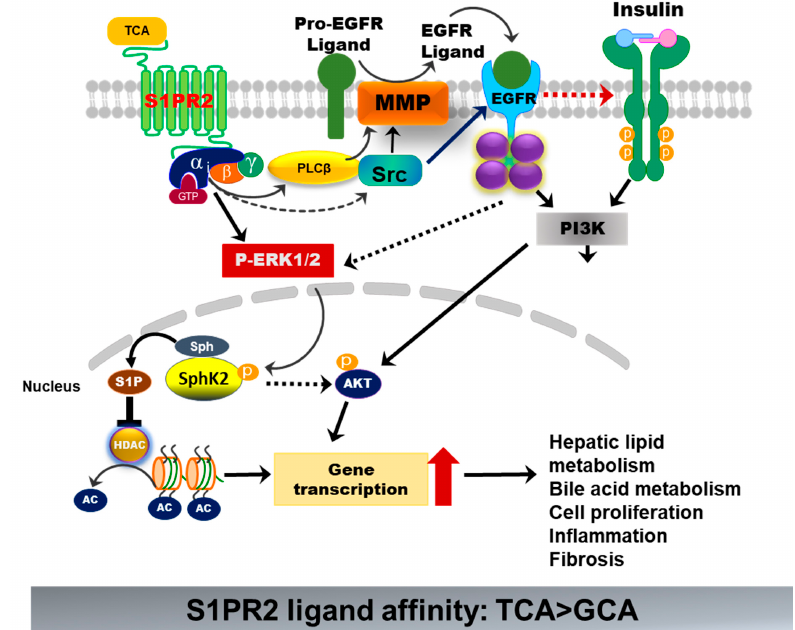
Figure 7. Bile-acid-induced activation of S1PR2. TCA-induced activation of S1PR2 in hepatocytes activates ERK1/2 and PI3K-Akt pathways. Activation of ERK1/2 further activates sphingosine kinase 2 (Sphk2), which generates S1P in the nucleus. S1P is a potent inhibitor of histone deacetylase (HDAC). Increased acetylation of histone promotes the transcription of key genes involved in hepatic metabolism, inflammation, cell proliferation, and fibrosis.